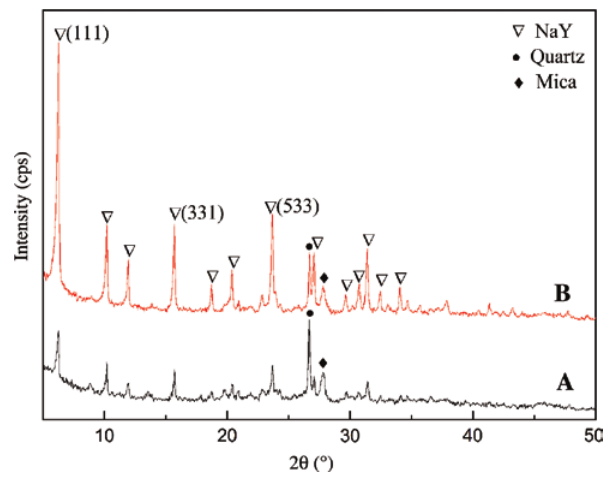
Figure 3: X-ray diffraction (XRD) patterns of (A) M-NaY-1 and (B)